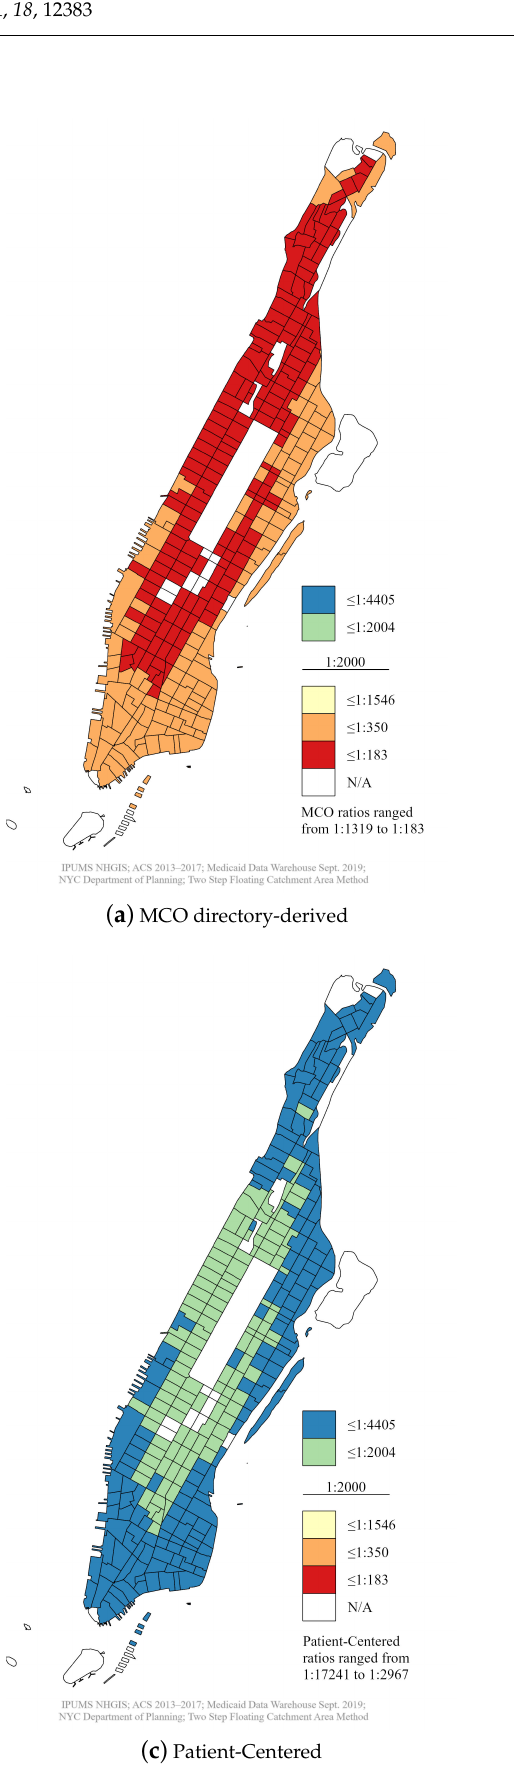
Figure 1. Medicaid dental supply in Manhattan census tracts, October